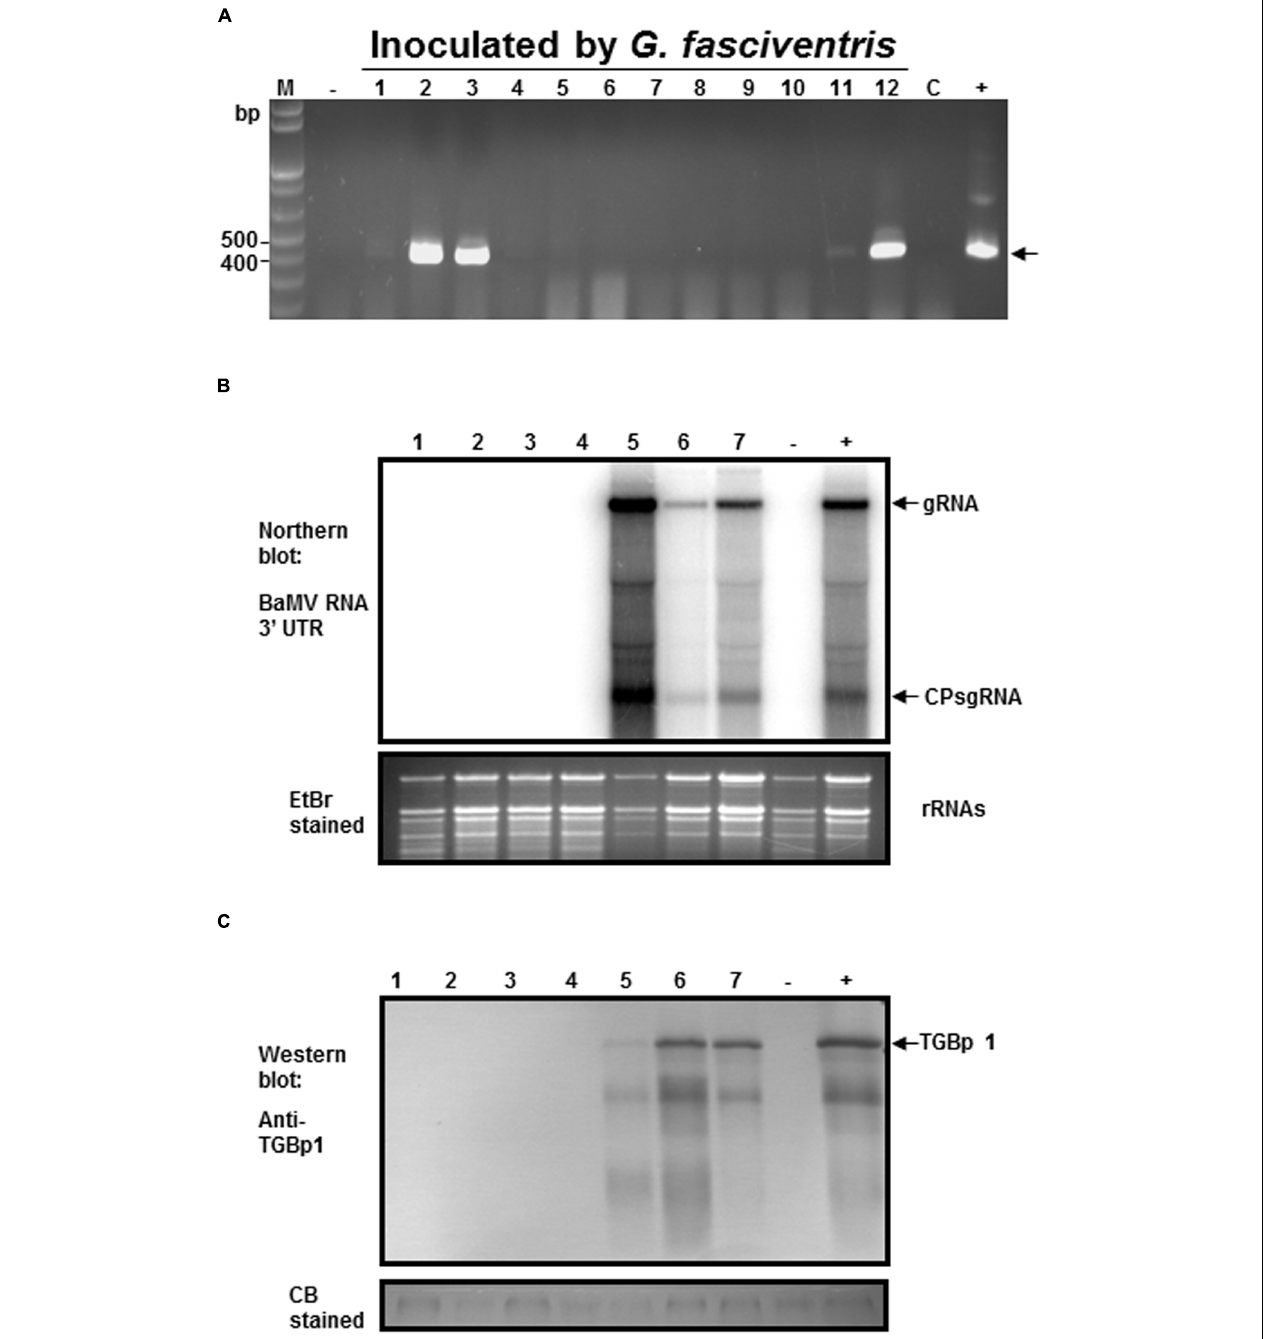
FIGURE 6 | Analysis of the G. fasciventris -mediate BaMV transmission by RT-PCR. (A) BaMV-free bamboo seedlings were inoculated by G. fasciventris fed with BaMV-containing medium in the insect domes. Samples were collected from the newly emerged leaves at the 60th day post inoculation (dpi), and subjected to total nucleic acid extraction and RT-PCR analysis as described above. Lane M, size marker; lane C, sample of cotton balls used for the feeding of the dipterans at the beginning of the experiment; lanes − and +, negative and positive controls as described in Figure 2 . To verify the inoculation results, northern (B) and western blot (C) were performed using 32 P-labeled probes specific for BaMV RNA 3 (cid:48) untranslated region (Hsu et al., 2000) or antibody against TGBp1 (Hung et al., 2014). Lanes 1–4, RNA or protein extracts of the un-inoculated siblings from the same mother-stock of the bamboo seedlings tested positive in (A) ; lanes 5–7, RNA or protein extracts from newly emerged leaves of seedlings tested positive for BaMV in panel A (samples #2, #3 and #12, respectively). Lanes − and +, samples from healthy and BaMV-infected bamboo plants, respectively. The positions of BaMV genomic RNA (gRNA), CP subgenomic RNA (CP sgRNA), and TGBp1 are indicated by the